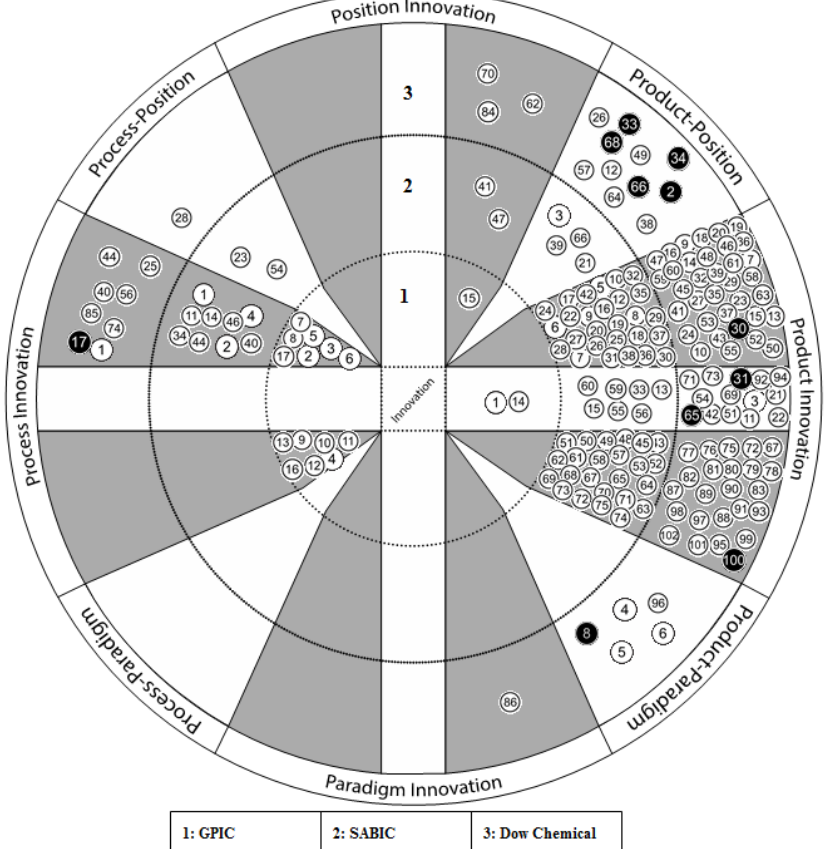
Fig. 6. Mapping Innovation of the Three International Petrochemical Companies from 2010 to